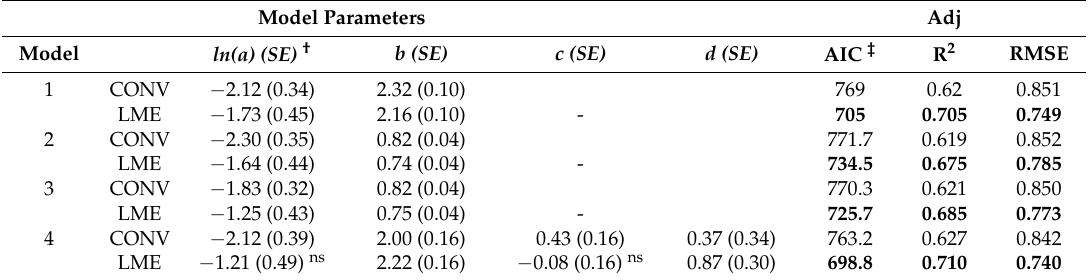
Table 2. Comparison of models fitted using the conventional (CONV) method with models fitted within a linear mixed effects (LME) framework where forest type was used as a random effect. The Akaike information criterion (AIC), adjusted R 2 (Adj R 2 ) and RMSE were used for comparing CONV with LMM.